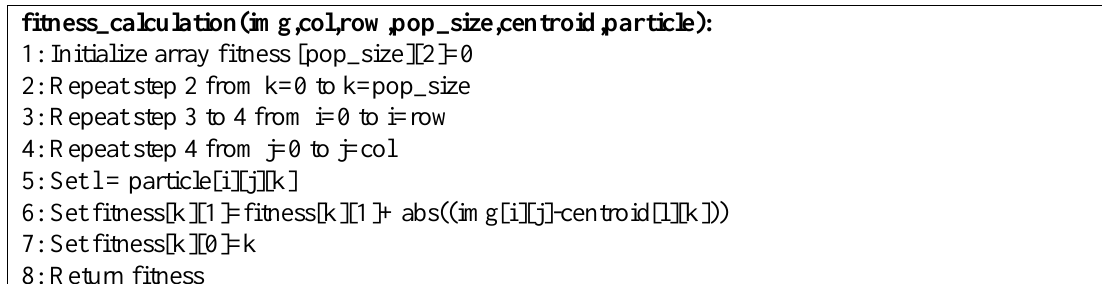
Algorithm 2. Function to calculate fitness function of each swarm of the particle.